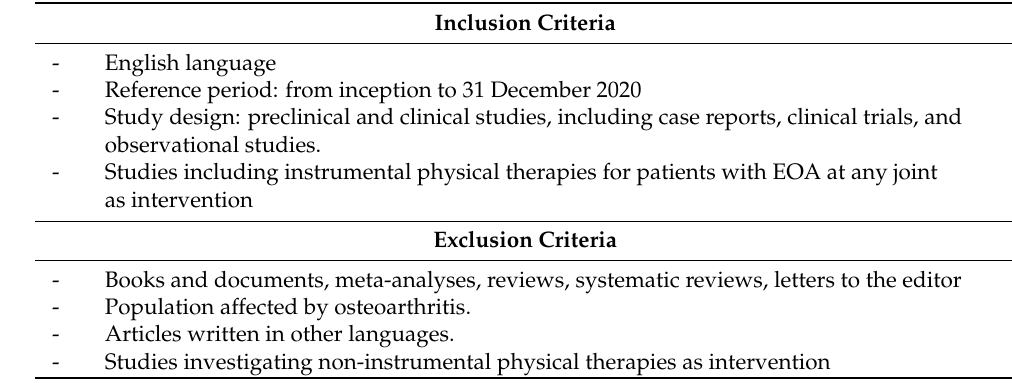
Table 2. Eligibility